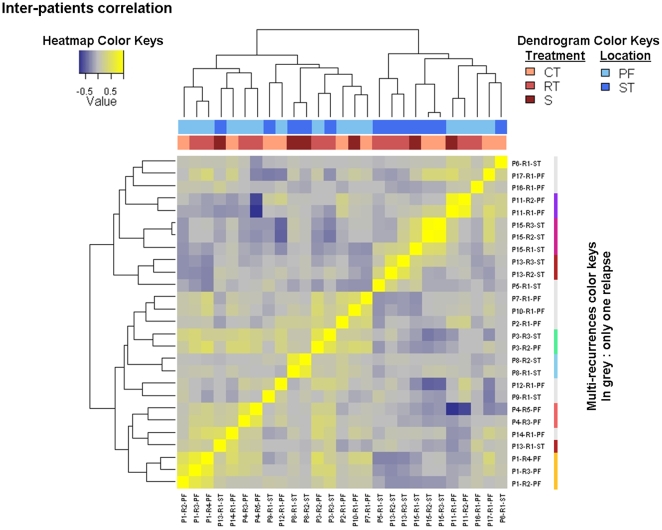
Correlation matrix of the gene expression signatures of the recurrences.After a low-stringent initial filtering (p≤0.01 in at least 20% of experiments), a subset of 29783 probes was used to measure the correlations between relapses (Pearson correlation). As expected, and because each relapse was co-hybridized with its own reference, 6 of the 7 multi-recurrence patients clusterized together. There was however no similar evolution of profiles according to relapse locations or to the treatments received before the recurrence. PF =  posterior fossa, ST =  supratentorial, RT =  radiotherapy, CT =  chemotherapy, S =  surveillance.